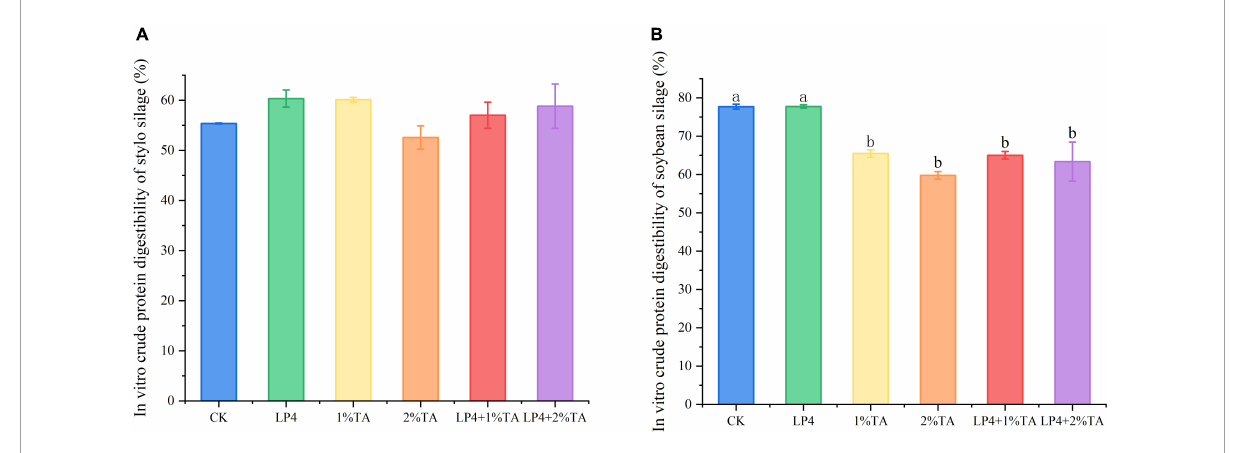
FIGURE3 In vitro crude protein digestibility of Stylosanthes silage (A) and whole-plant soybean (WPS) silage (B) in 48 h. Different letters over the bars indicate significant differences ( P < 0.05).